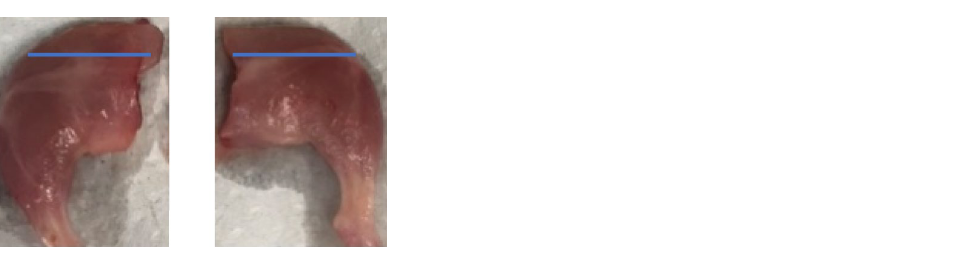
Figure 6. A representative necropsy image of muscles of the injected (right) vs. control (left) hind legs. The blue lines indicate where the cranial leg measurements were taken.